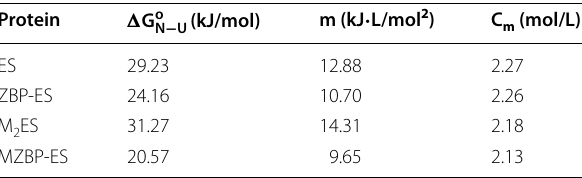
Table 1 Parameters of the GdmCl-induced unfolding of ES